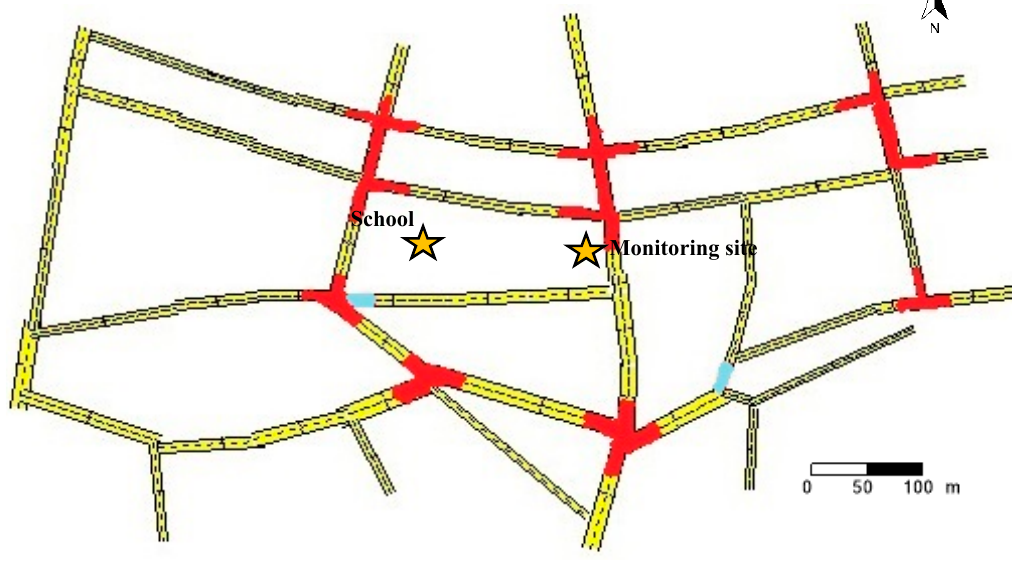
Figure 1. Modelled area. (Calibrated roads (red) and validated roads (cyan)).